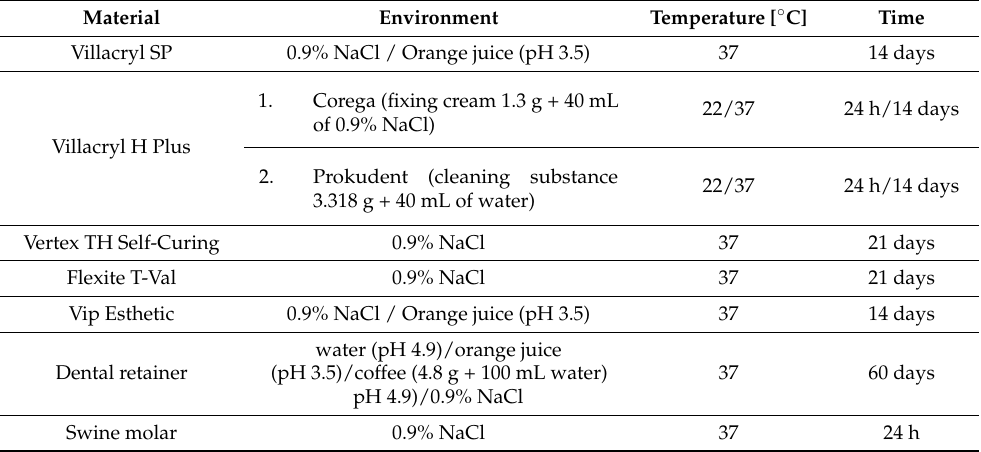
Table 2. Conditions of samples incubation.